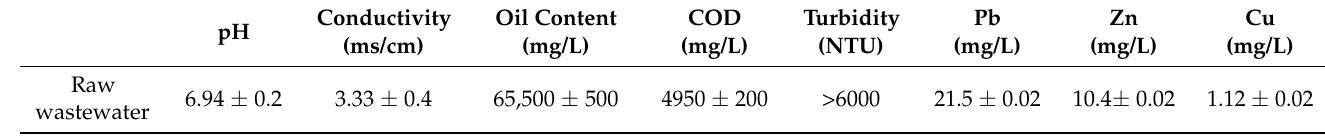
Table 2. Main characteristics of the raw wastewater coming from the electroplating industry.